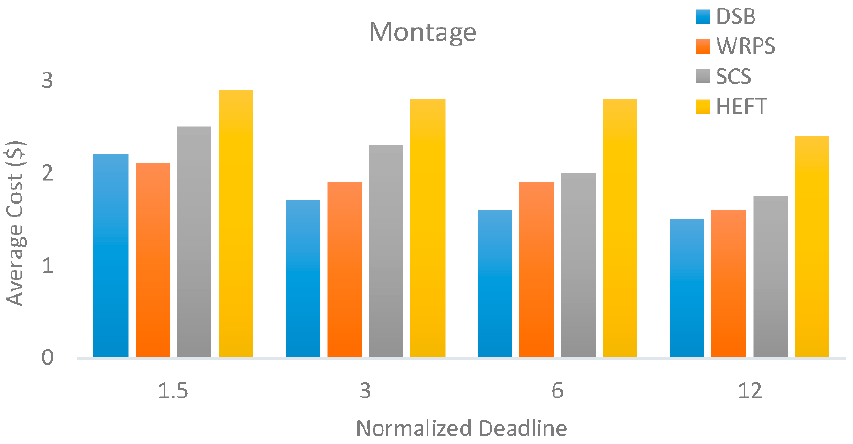
Figure 3. Average cost of Montage under varied normalized deadlines.